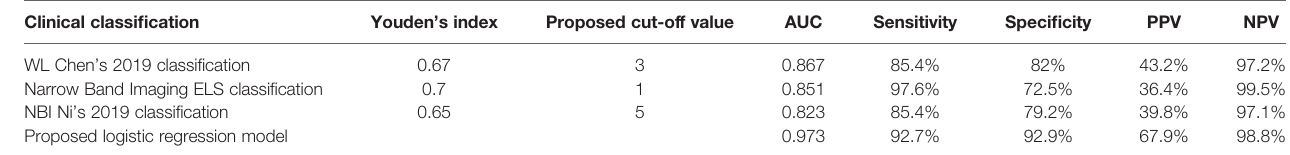
TABLE 3 | Diagnostic performance of the analyzed endoscopic classi fi cations and proposed cut-off values for determining the risk of cancer development under vocal fold leukoplakia. Clinical classi fi cation